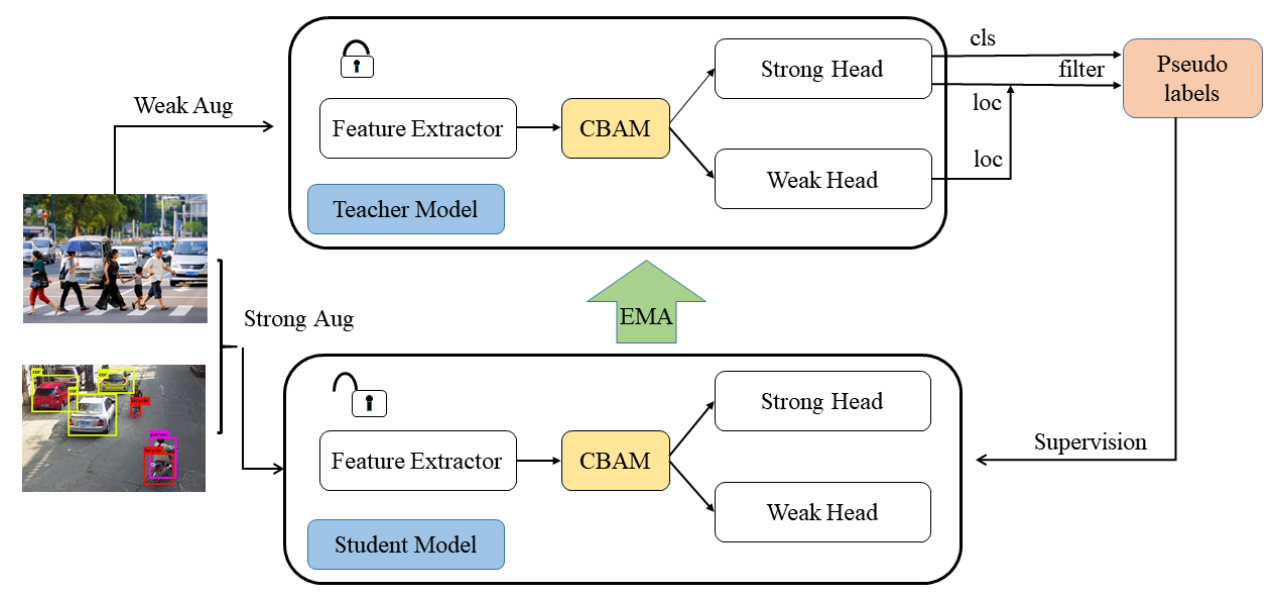
Figure 1. The overview of the proposed framework.